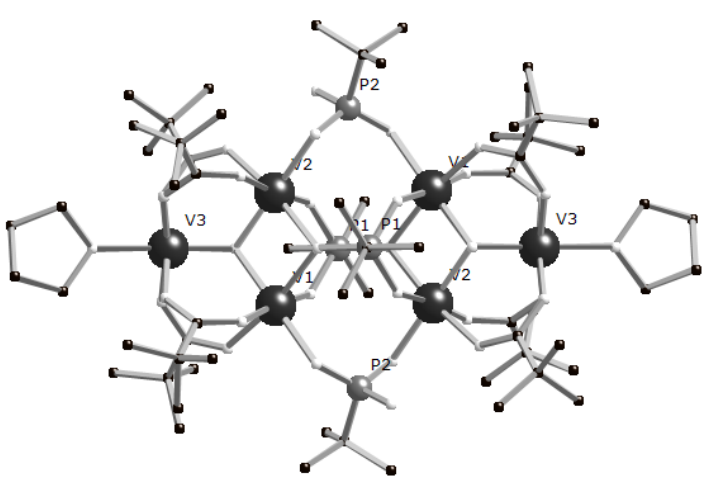
Figure 1. Structure of 2 in the